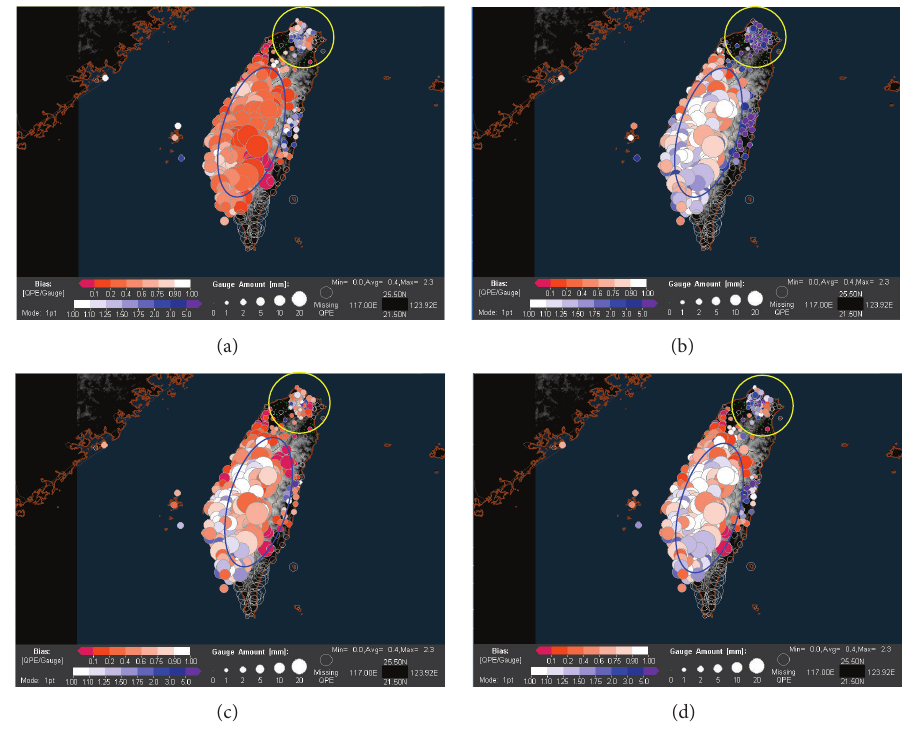
Figure 10: Comparison of the ratio of QPEs/gauges from (a) RZ, (b) RKDP, (c) CA, and (d) VCCA approaches. One-hour accumulated precipitation in the range 2000 ∼ 2100 UTC 8 August 2009 is used in the evaluation. The size of the circles represents the gauge observed rainfall amount and the color shows the ratio: the warm (orange), cold (blue), and white colors indicate underestimation, overestimation, and accurate estimation,